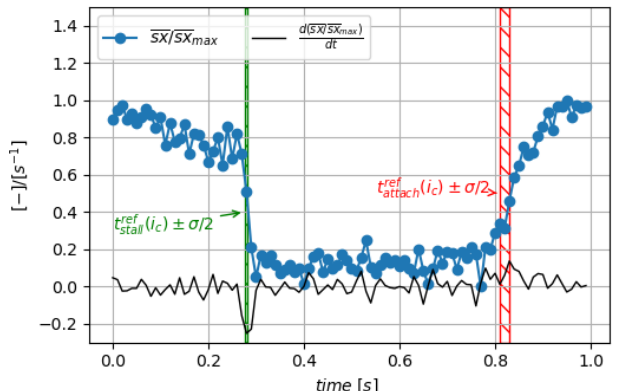
( i c ), and void circle sym- stall ( i c ). attach